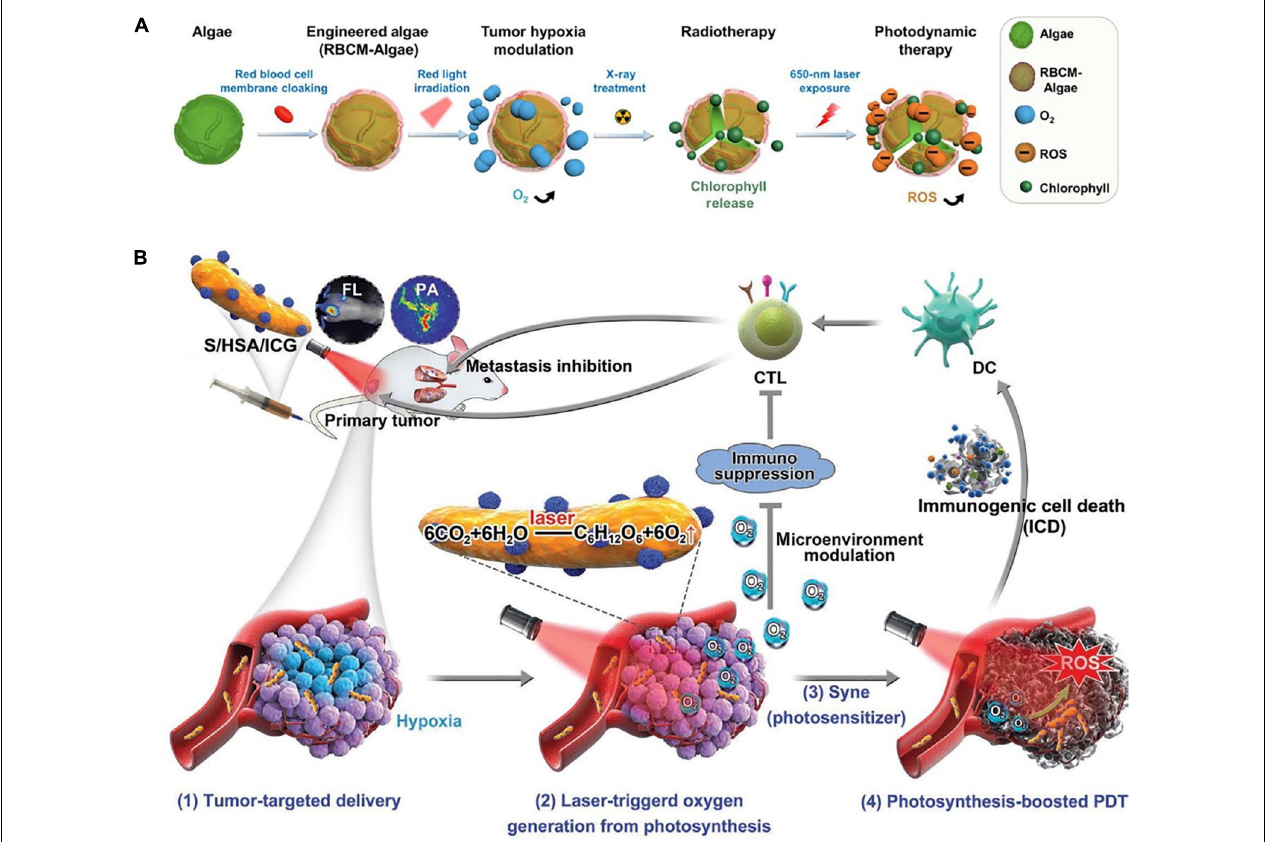
FIGURE 2 | (A) Demonstration of the microalgae engineered treatments. (B) Human serum albumin (HSA)/indocyanine green (ICG) in situ generated O 2 through photosynthesis to enhance photodynamic therapy (PDT) efficacy and induce immunogenic cell death (ICD)-mediated antitumor immune activities (122) (Copyright permission: